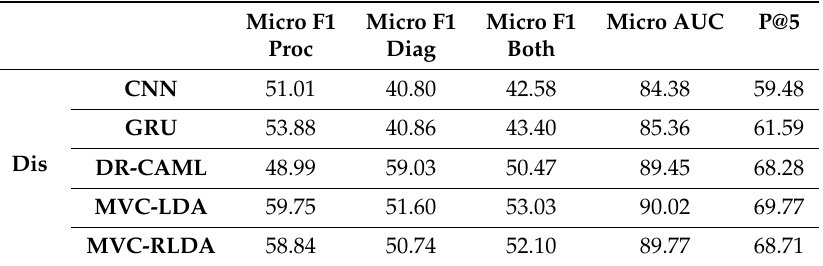
Table 4. Results of flat models on all labels of the MIMIC-III Dis dataset.